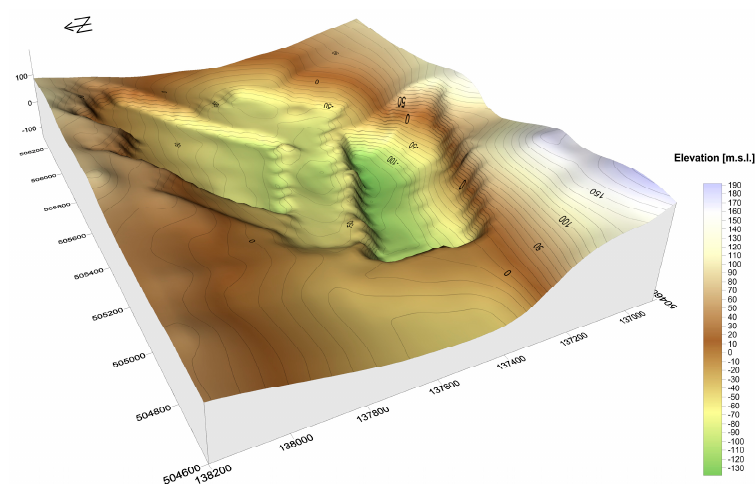
Figure 3. A 3D elevation map of the Pl ‐ 1 and Pl ‐ 2 variety of Pliocene water ‐ carrying sands in the year 2017. Pumping wells are not anymore present and the Pl ‐ 1 and Pl ‐ 2 geometry due to excavation works will change.